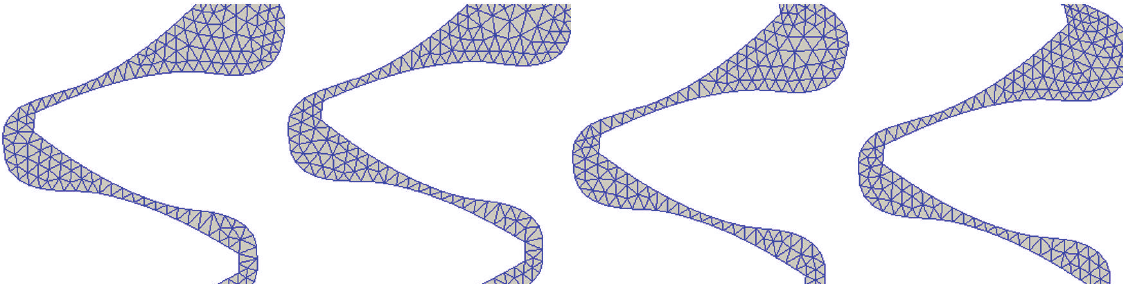
Figure 2: Detail of the first 4 meshes (symmetry plane); before mapping the data, the (𝑖 − 1) th mesh is deformed so that its boundary will coincide with the boundaries of the 𝑖 th mesh.